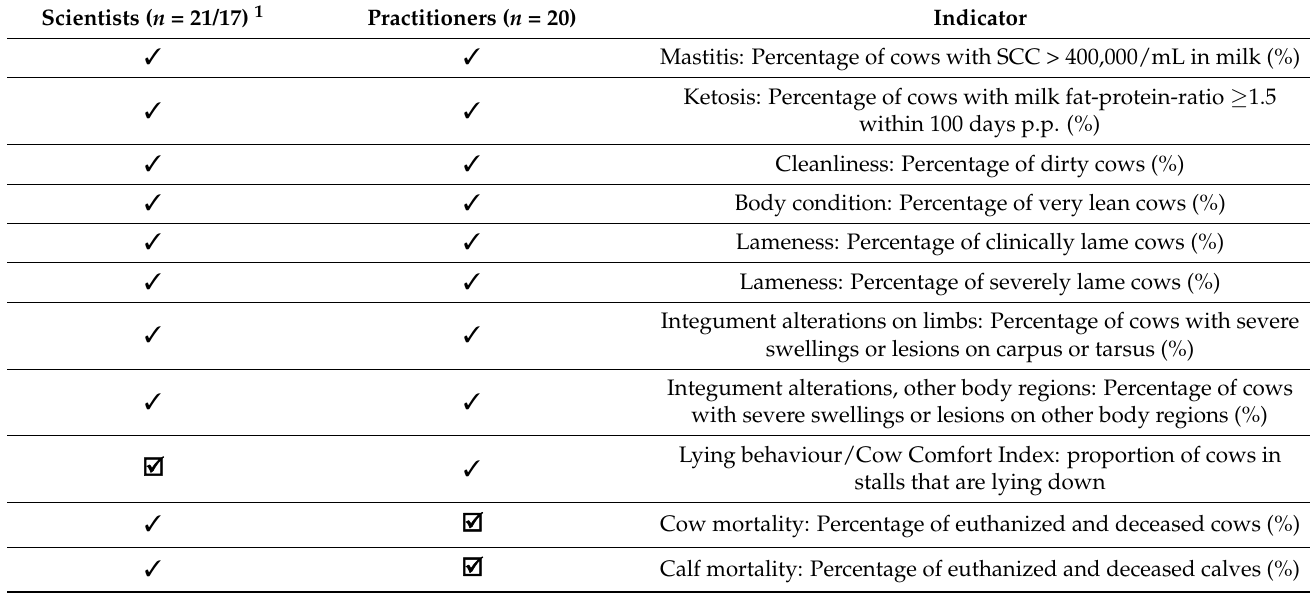
Table 2. Scientists and practitioners indicator selection.